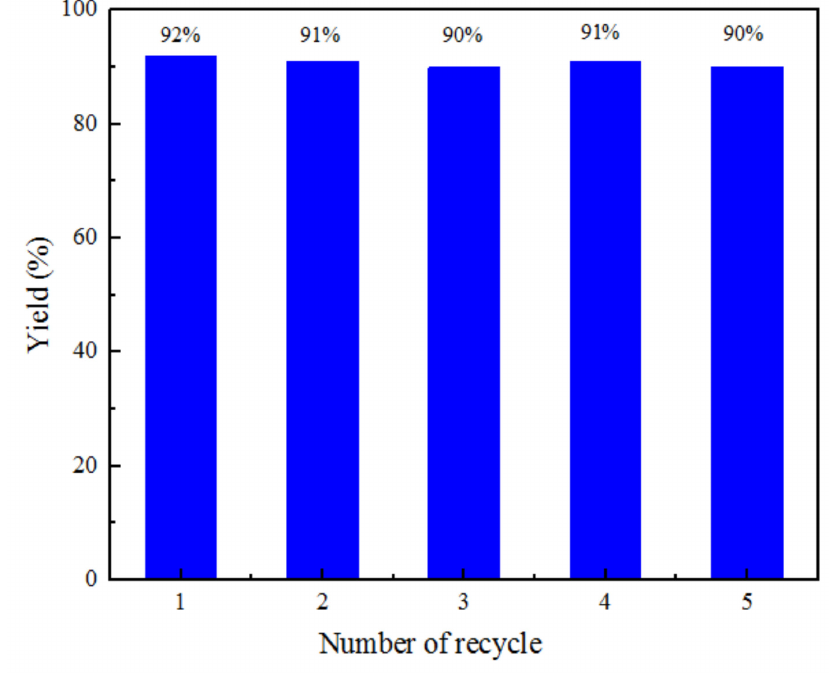
Figure 1. Recovery and reuse of copper